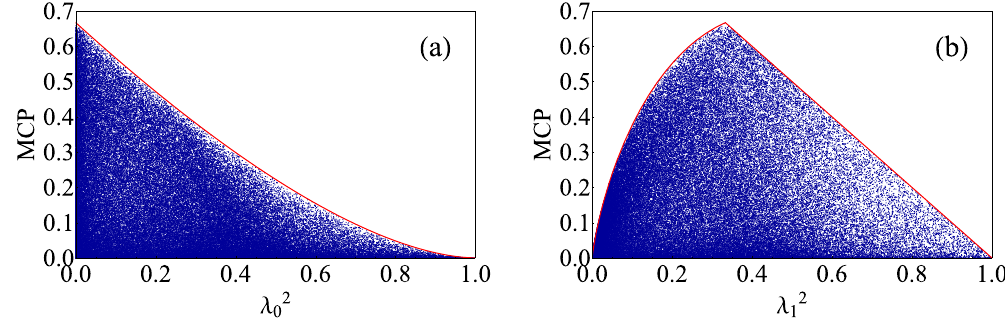
Figure 2. MCPs of randomly generated extended W states. ( a ) MCPs of randomly generated extended W states plotted against λ 02 . The solid curve corresponds to MCPs of extended W states that have λ 1 = λ 2 = λ 3 with λ 02 ’s given. ( b ) MCPs of randomly generated extended W states plotted against λ 12 . The solid curve corresponds to the MCPs of extended W states that have λ 0 = 0 and λ 2 = λ 3 with λ 12 ’s